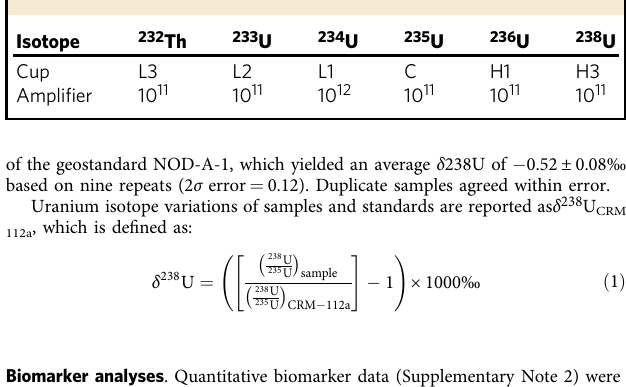
Fig. 3 Example of a freshly exposed reduction spheroid. This spheroid shows a distinctive dark grey core, a bleached halo and a red-brown matrix fl ecked with smaller reduction spots. The coin is ~21 mm across. Devonian red sandstone, Millport, Great Cumbrae, Ayrshire, Scotland Table 1 Neptune Faraday detector